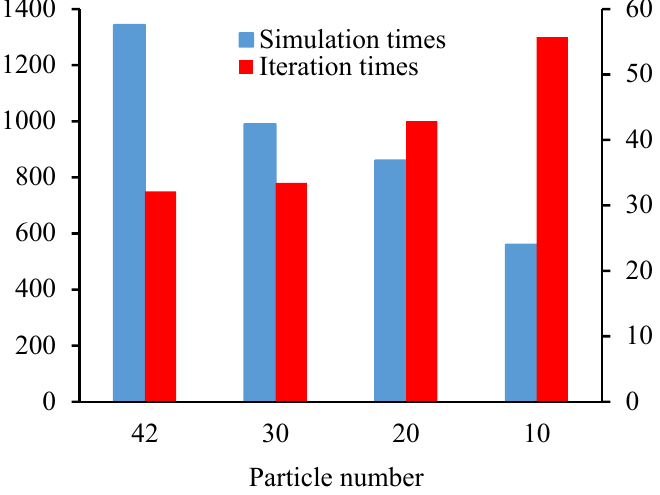
Figure 10. Iteration times and simulation times.